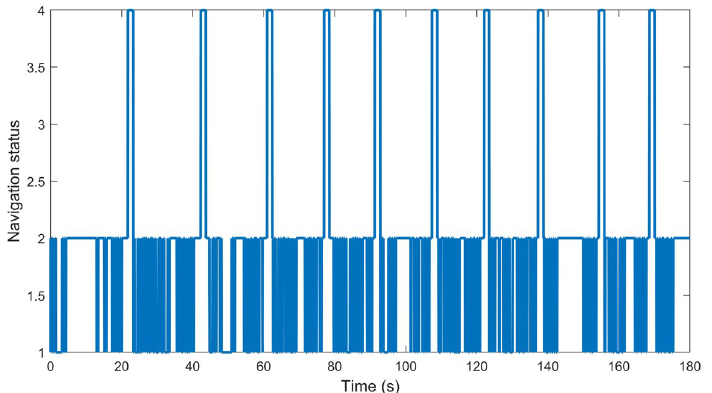
Figure 14. Navigation status change trend.